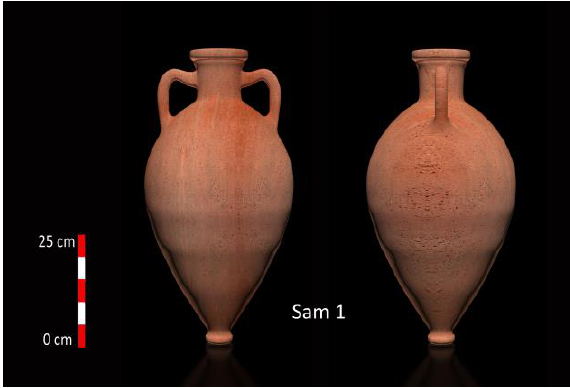
Figure 12. A Samian amphora from 550-500 BC.